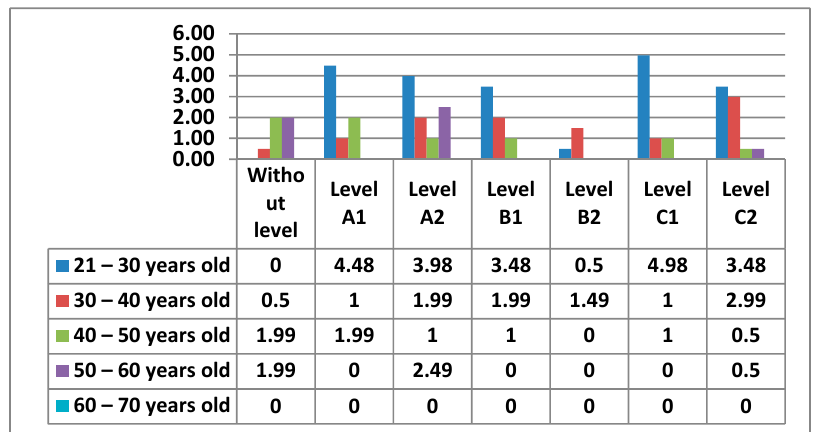
Figure 19. Digital competence in teachers by age in Area 3.